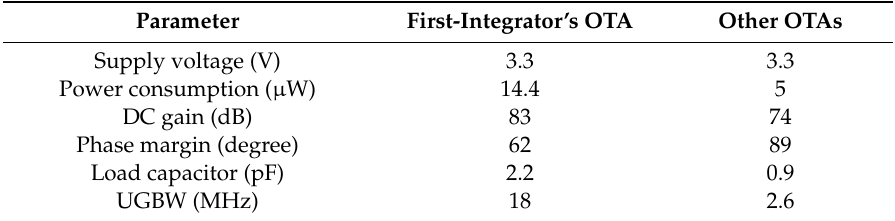
Table 3. Circuit simulation results of the OTAs.